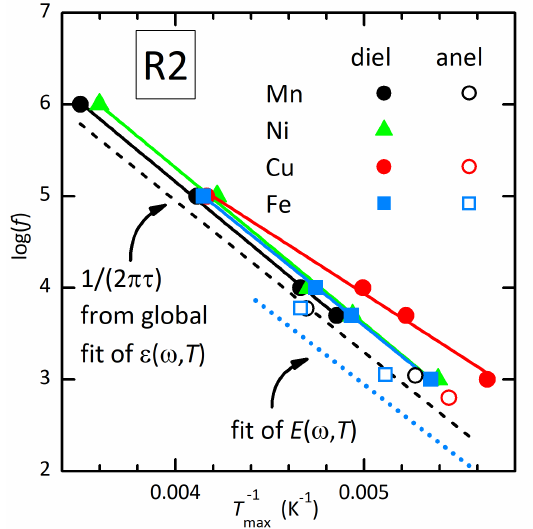
Figure 8. Arrhenius plot of the temperatures of the peaks of tan δ and Q − 1 corresponding to R2. The dashed line is ( 2 πτ ) − 1 from the global fits of the dielectric spectrum of TMCM-Mn 3 and the anelastic spectrum of TMCM-Mn 0.95 Fe 0.05 Cl 3